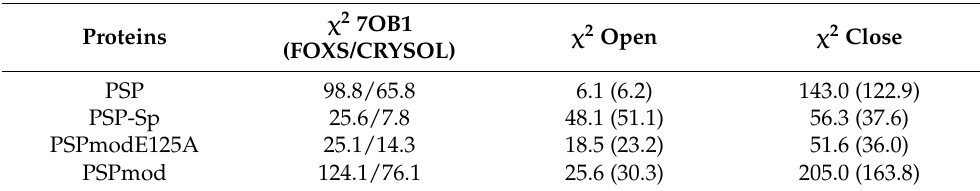
Table 5. Chi squares ( χ 2 ) for the comparison of experimental SAXS profile with theoretical generated by FOXS/CRYSOL programs for the models of PSP